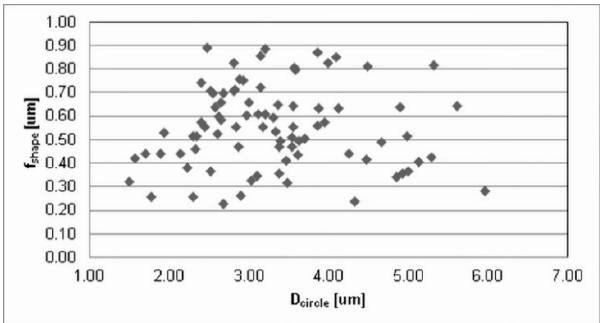
Figure 10. The dimensional and morphological characteristics, f shape , of porosity for ECAPed specimens (400 MPa). Materials 2019 , 12 , x FOR PEER REVIEW